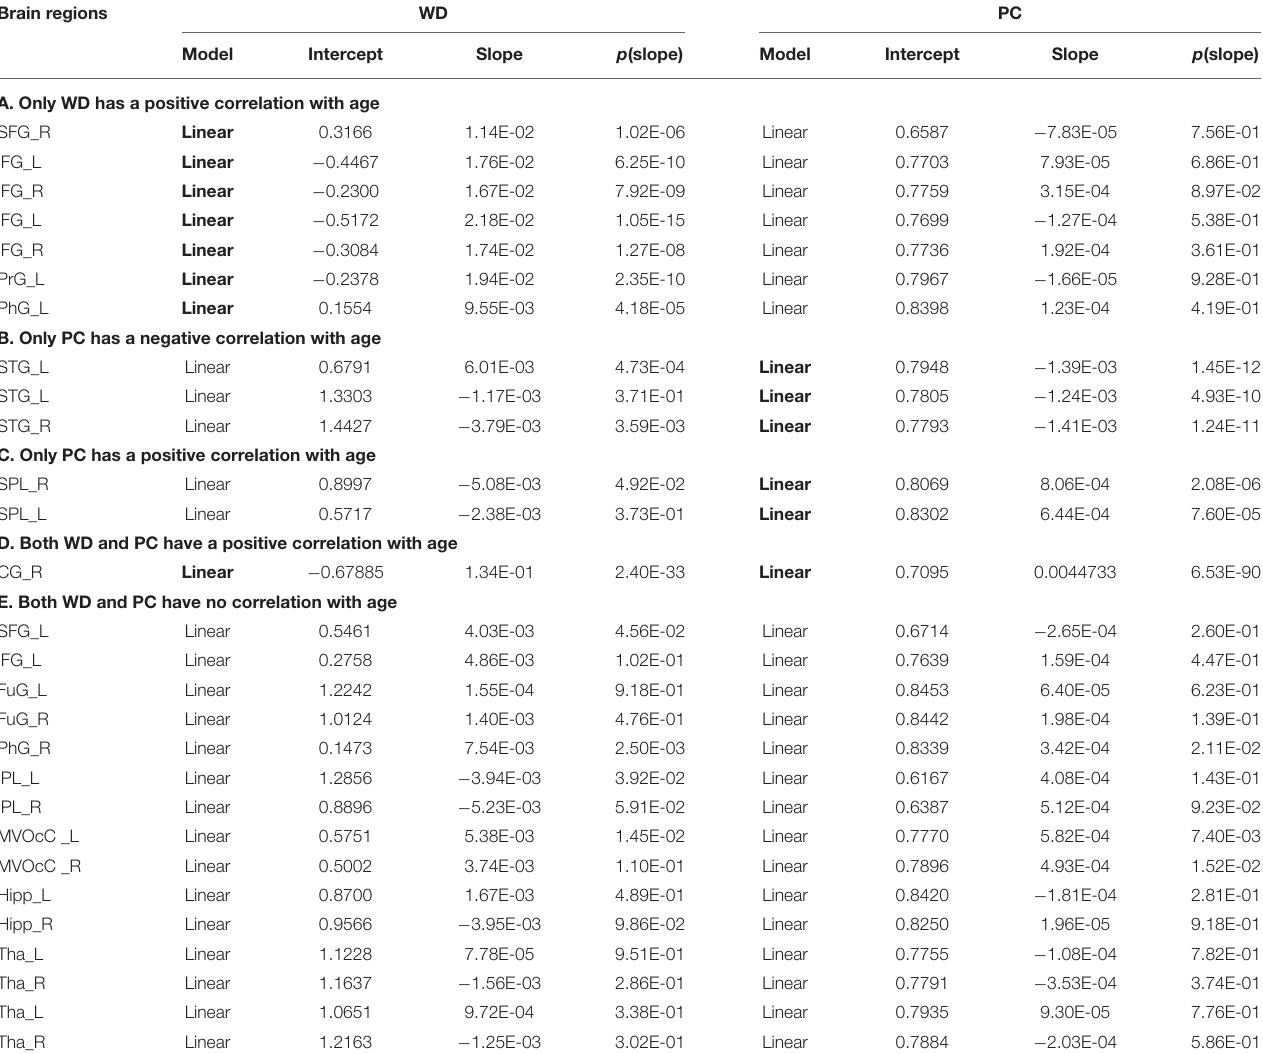
TABLE 1 | Fitted correlation curves of WD and PC of selected hubs in the Young - Middle age stage. Brain